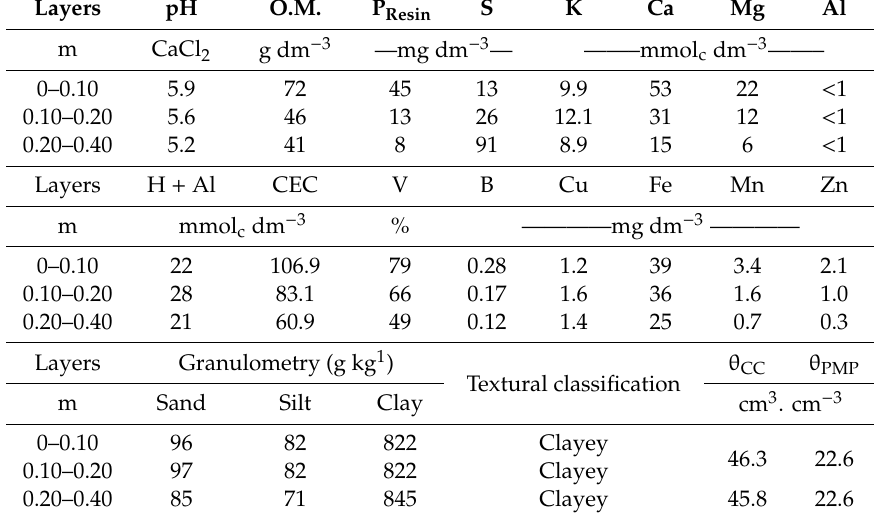
Table 1. Chemical, physical–water, granulometry, and soil textural classification of the